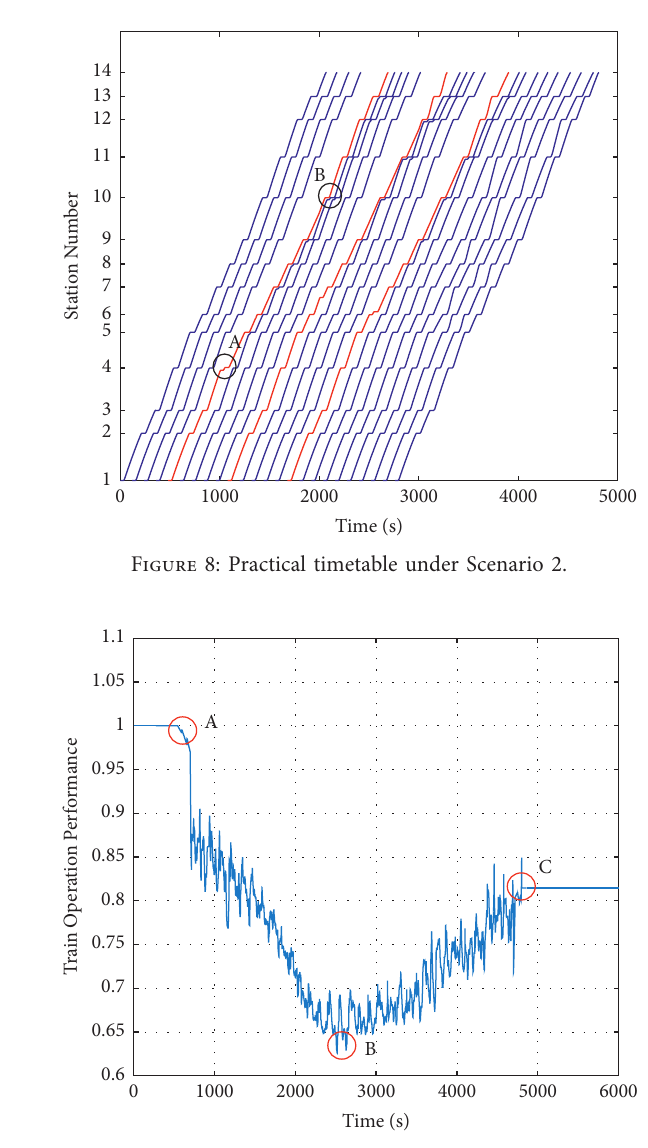
Figure 9: The train operation performance of the subway line under Scenario 1.